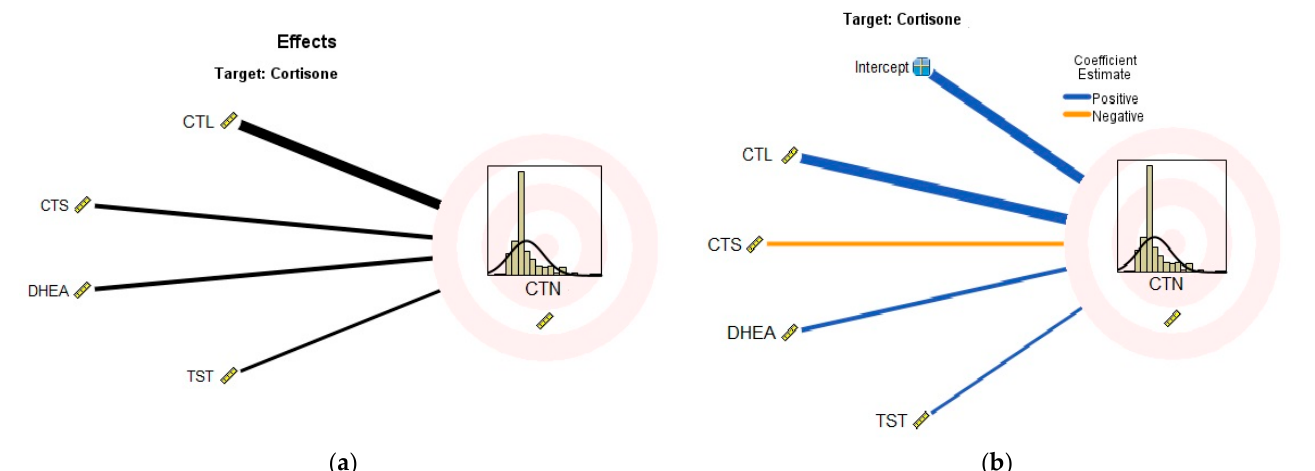
Figure A2. The forward stepwise model selection method results presented for Model 2 after automatic linear modelling: ( a ) the identified effects of the predictors on cortisone (CNT) levels by cortisol (CTL), task cohesion (CTS), dehydroepiandrosterone (DHEA), and testosterone (TST) and ( b ) the negative and positive coefficient estimations that were identified in Model 2 for cortisone (CNT) levels by cortisol (CTL), task cohesion (CTS), dehydroepiandrosterone (DHEA), and testosterone (TST).